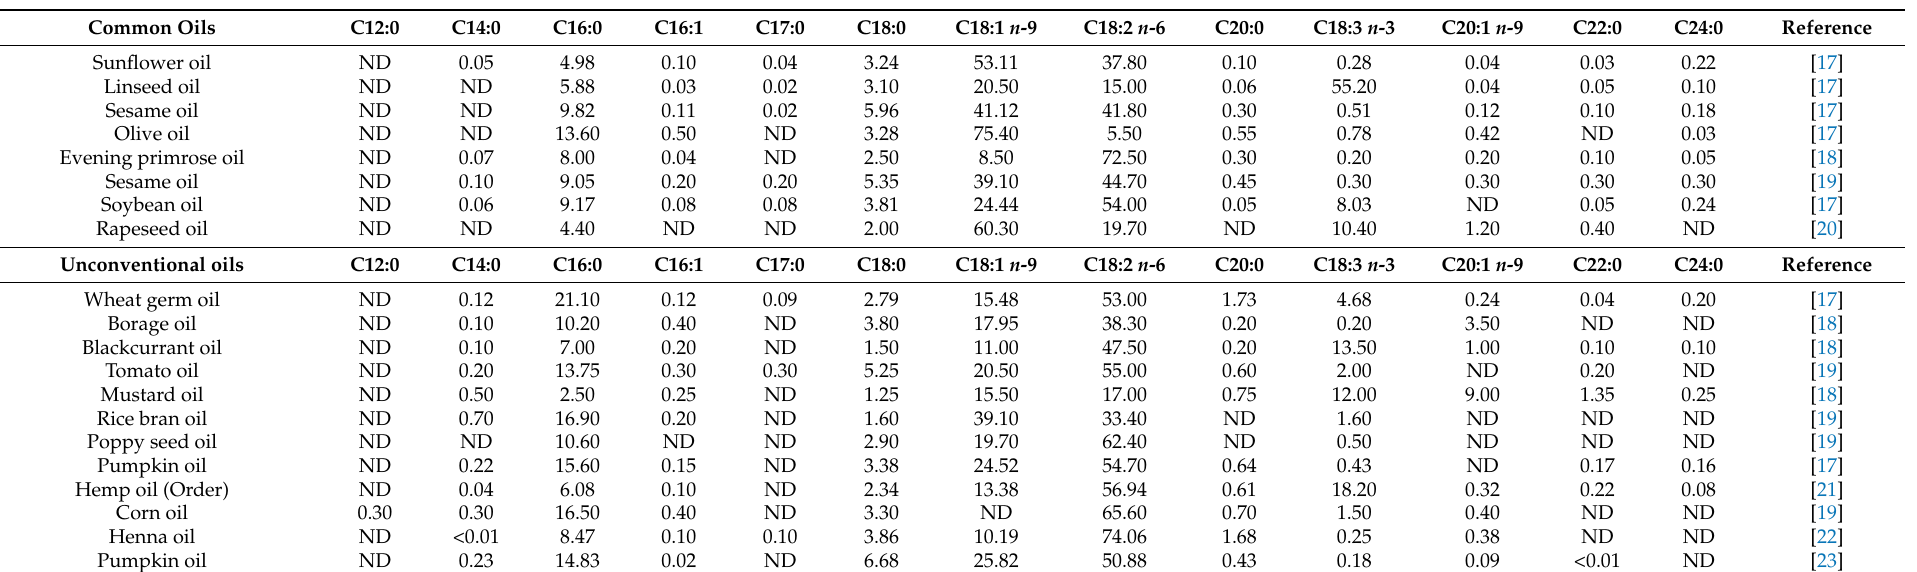
Table 2. Fatty acid composition of different types of seeds and fruits oil, and nuts